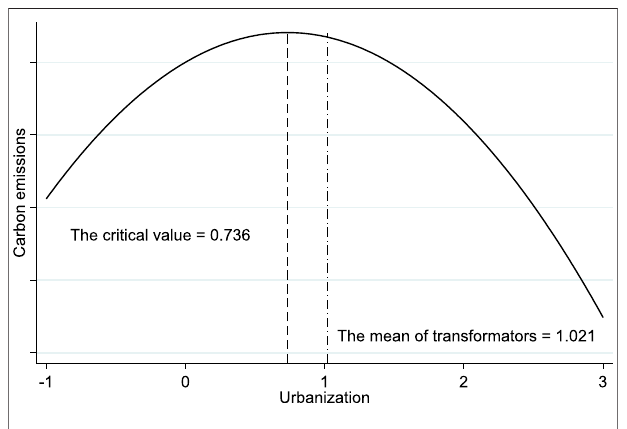
FIGURE 4 | The transformative role of government